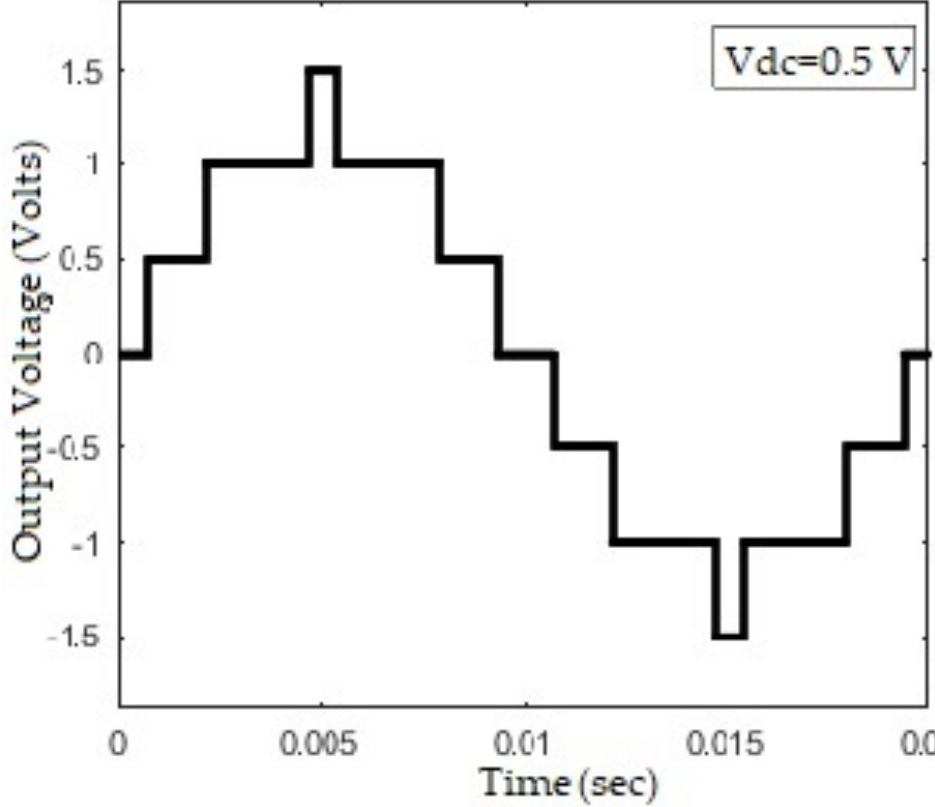
Figure 2. Multilevel output voltage waveform.